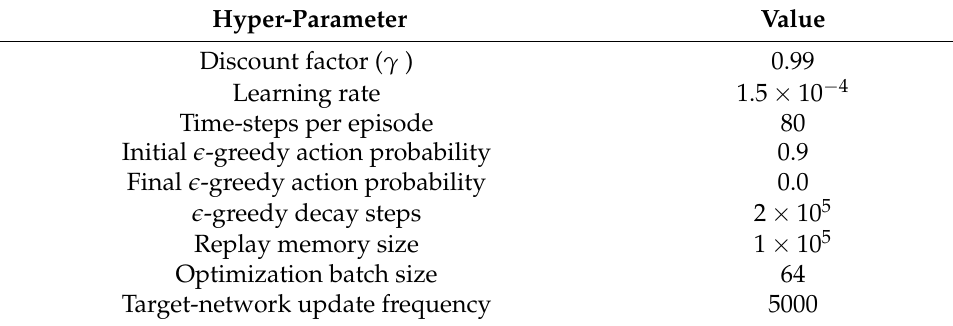
Table A2. List of hyper-parameters’ values for our training